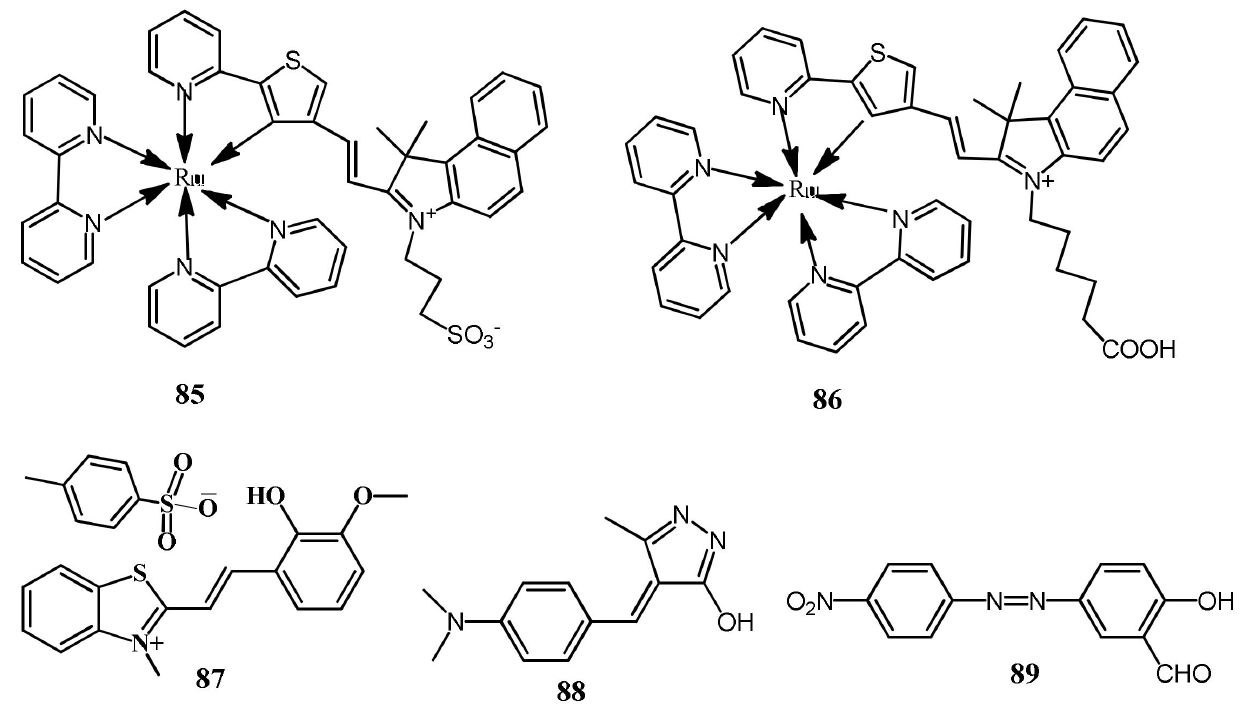
Figure 28. Molecular structures of the sensors 85 to 89 .